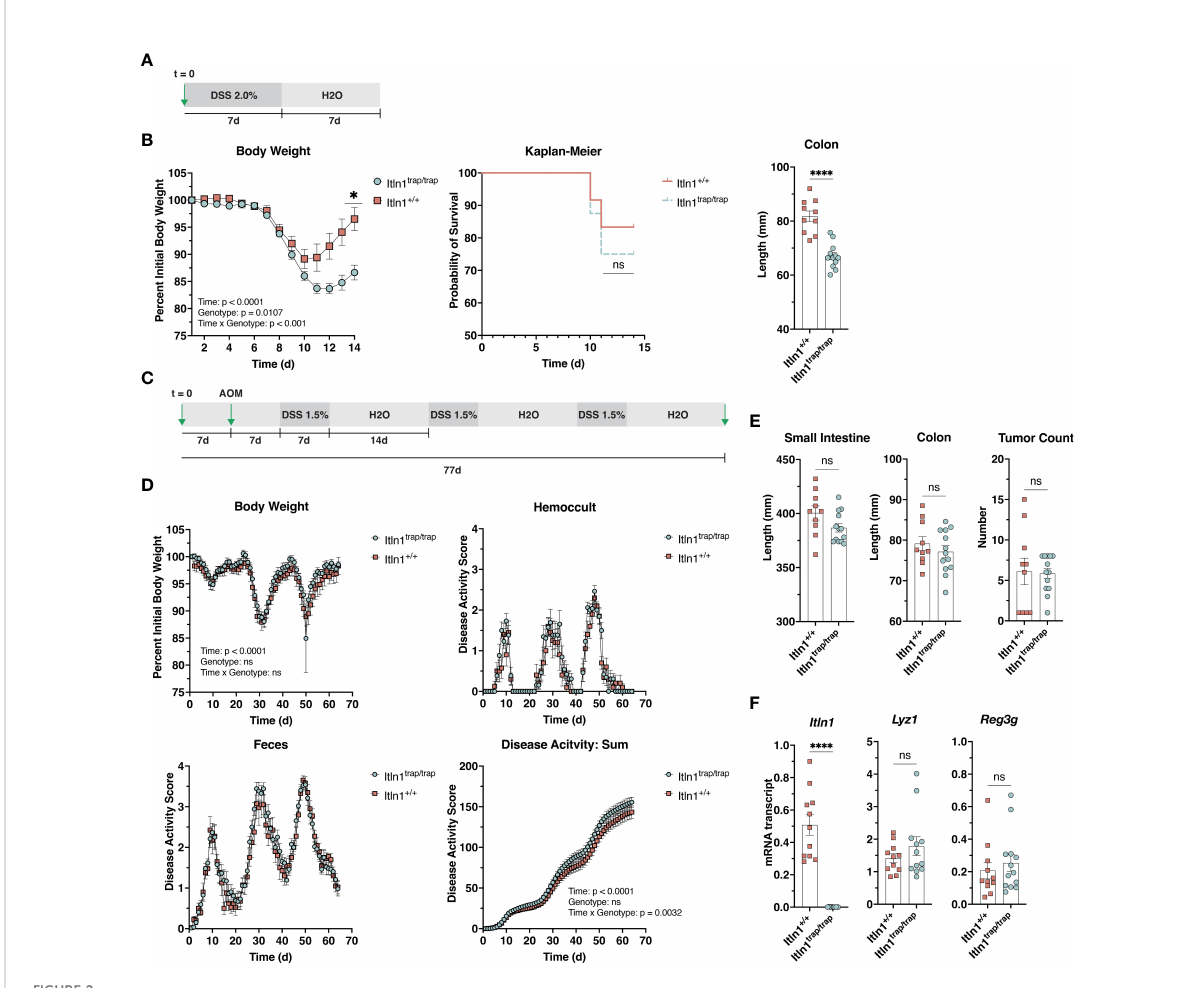
FIGURE 2 Response of Intelectin-1 knockout mice and wild-type littermates to challenge with DSS. (A) Treatment schematic for DSS colitis model. (B) Body weight, Kaplan-Meier survival curve, and colon length at necropsy (d 14) for Itln1 +/+ (n = 10-12) and Itln1 trap/trap (n = 12-16) mice. (C) Treatment scheme for AOM-DSS chronic colitis model. (D) Body weight and disease activity parameters were assessed daily from the initial day of DSS administration to necropsy (total time = 63 d) in Itln1 +/+ (n = 10) and Itln1 trap/trap (n = 13) mice. (E) Small intestine length, colon length, and colonic tumor number at necropsy. (F) Distal (last 5 cm) small intestine mRNA expression of Paneth cell effectors in Itln1 +/+ and Itln1 trap/trap mice. Statistical analysis of body weight (B) and disease activity (D) was performed using repeated measures two-way ANOVA with Greisser- Greenhouse correction and Sidak multiple comparisons test. Survival analysis was performed by Chi square. Comparisons of tissue length and gene expression were performed using two-tailed, unpaired T-tests with Welch ’ s correction. p < 0.05 (*), p < 0.0001 (****), ns, non-signi fi